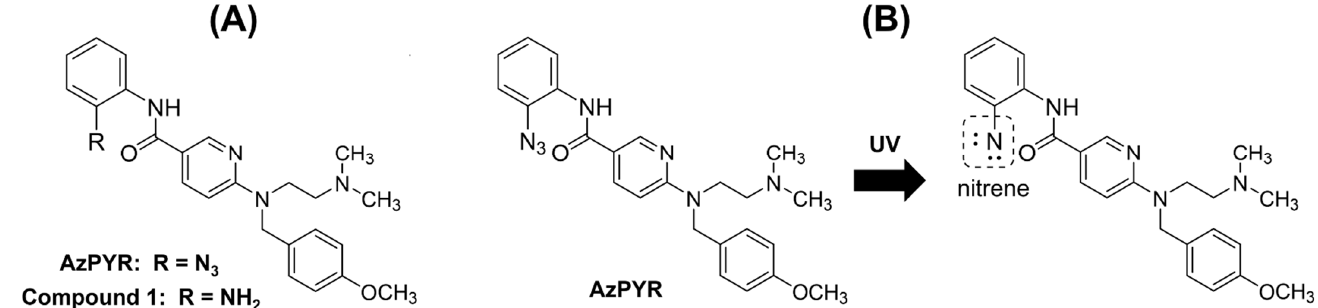
Figure 1. ( A ) Chemical structures of AzPYR and compound 1 . ( B ) Production of the phenyl nitrene moiety, which forms a covalent bond with the H + /OC antiporter.